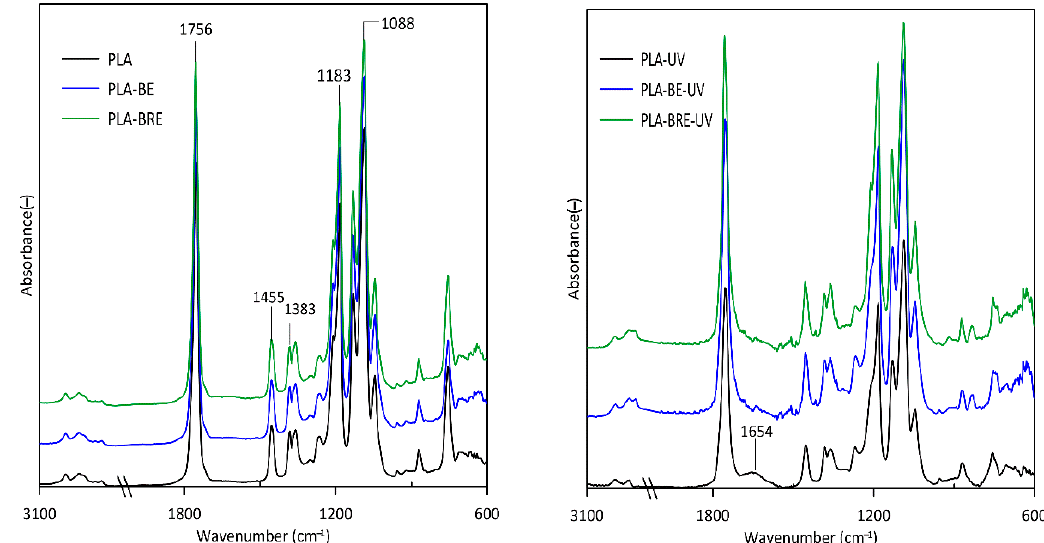
Figure 11. FTIR spectra for the PLA and PLA composite films prior to and following exposure in a UV chamber.